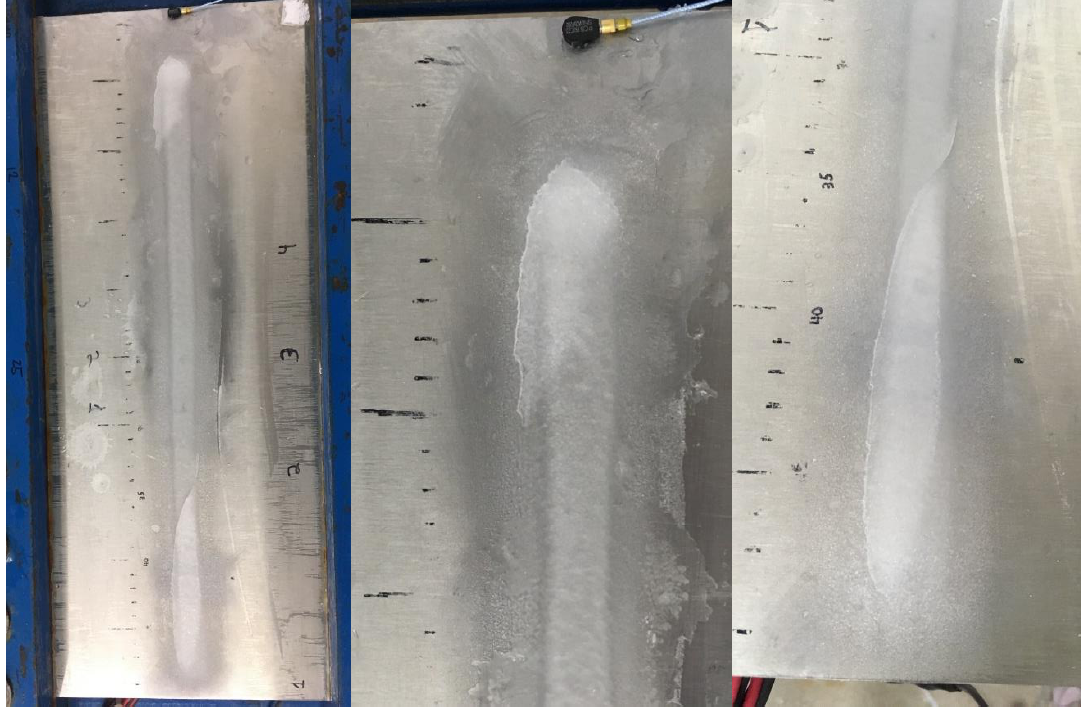
Figure 18. Delamination of the ice layer in steady-state mode activation at 1138 Hz and 340 Vpp.